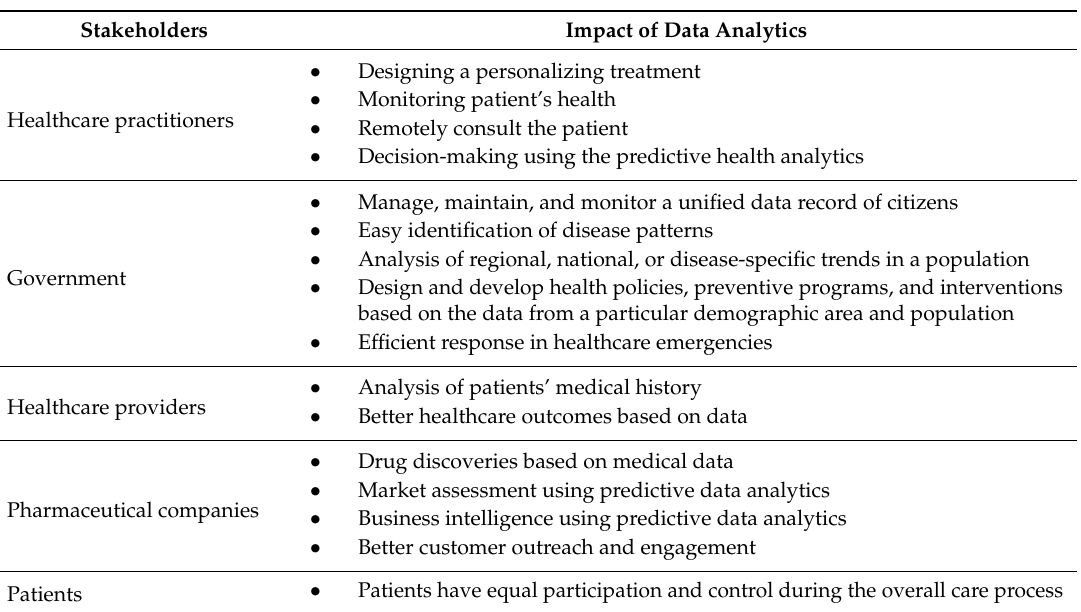
Table 1. Data analytics assisting the